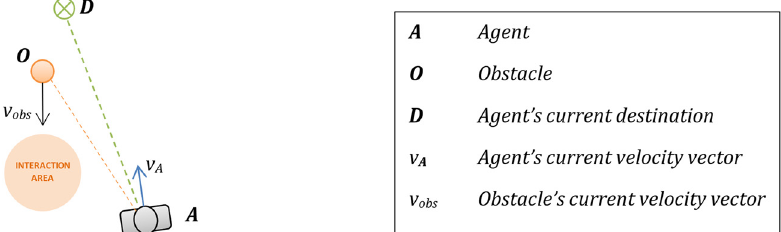
Figure 1: Pedestrian interacting environment